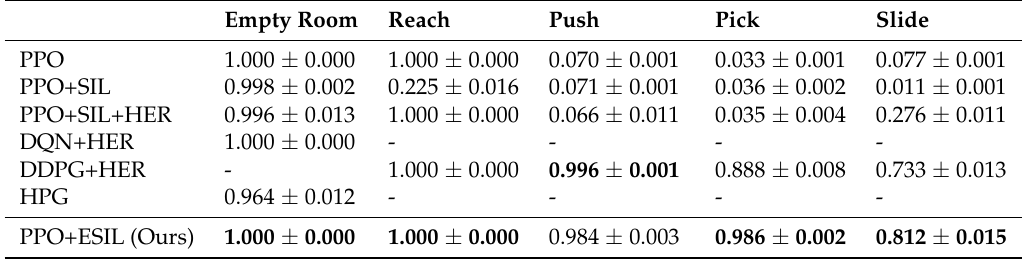
0.964 ± 0.012 - - - - PPO+ESIL (Ours) 1.000 ± 0.000 1.000 ± 0.000 0.984 ± 0.003 0.986 ± 0.002 0.812 ±